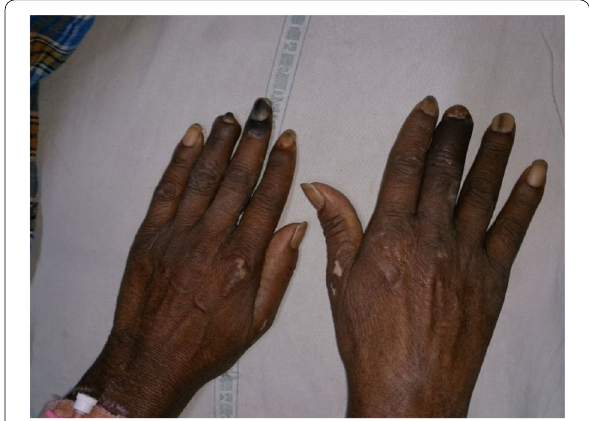
Fig. 1 Showing left middle finger gangrene and index finger